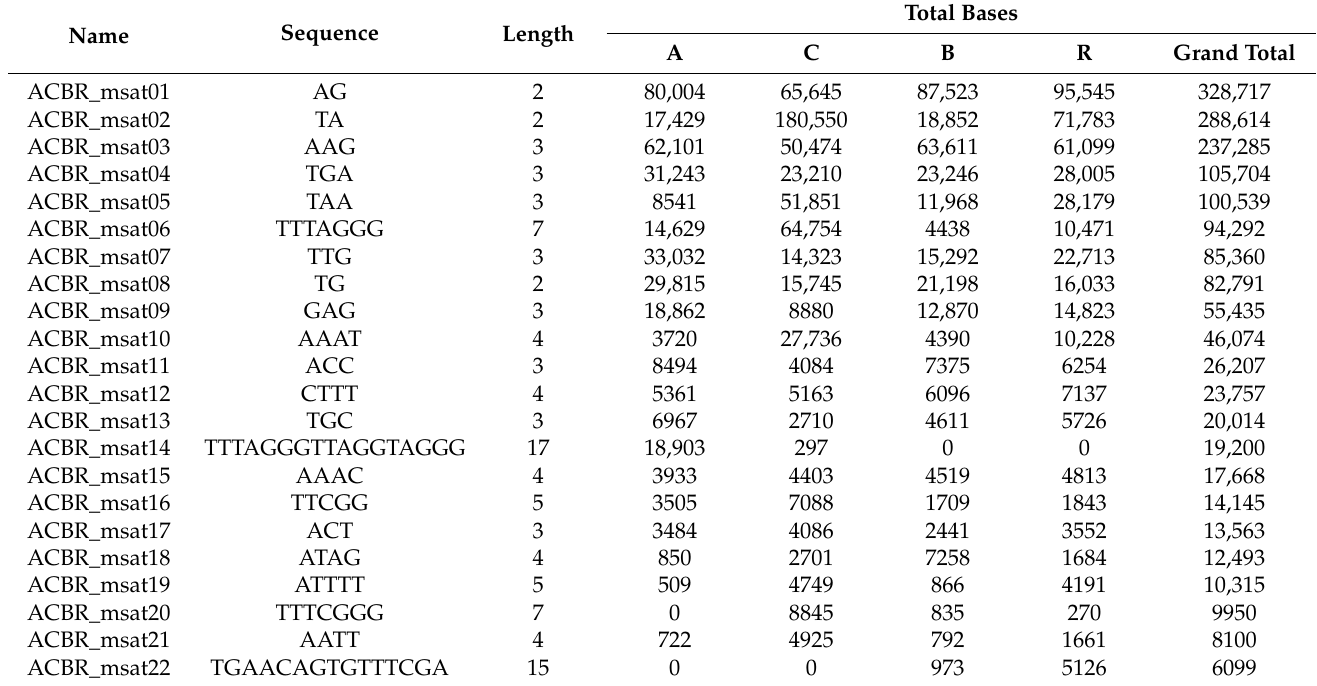
Table 3. Summary of top 22 microsatellites identified in the A, C, B, and R